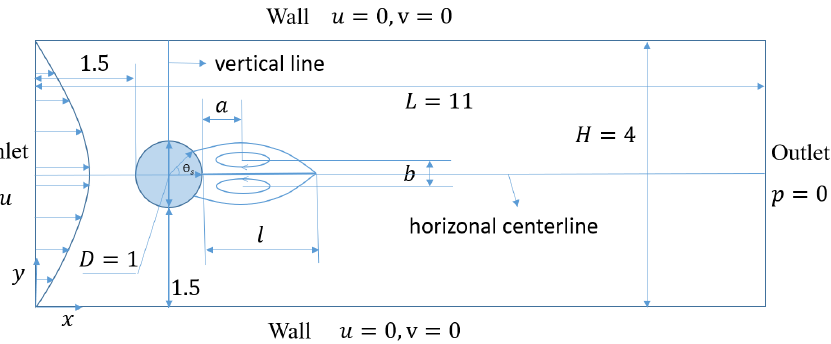
Figure 3. A schematic diagram of the computational domain and boundary conditions for the problem of flow over a circular cylinder placed in a